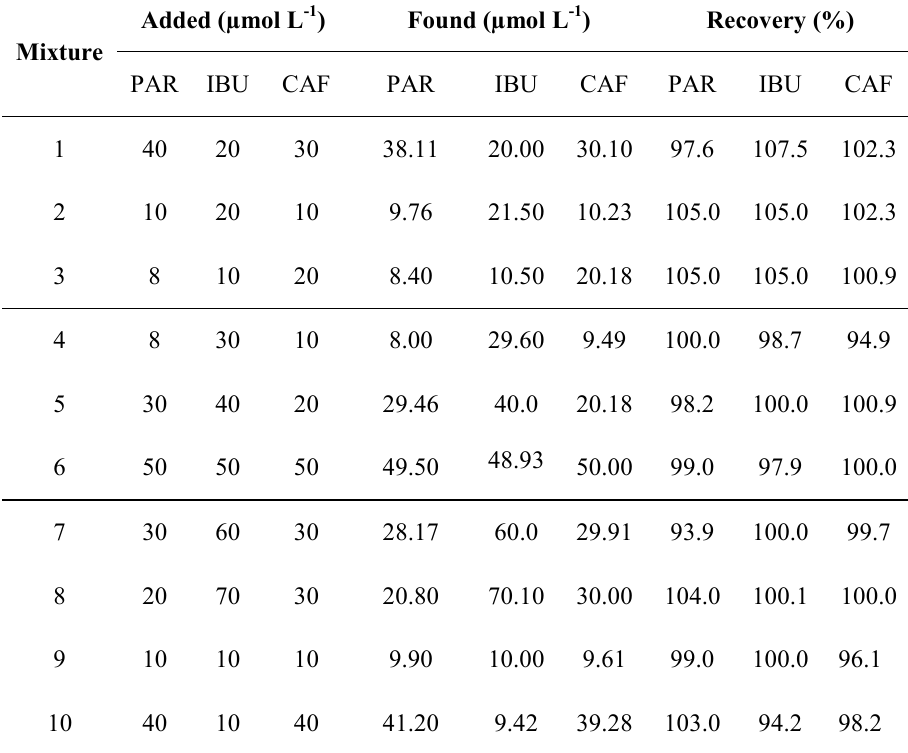
Table 2. Determination of paracetamol, ibuprofen and caffeine in some ternary mixtures.